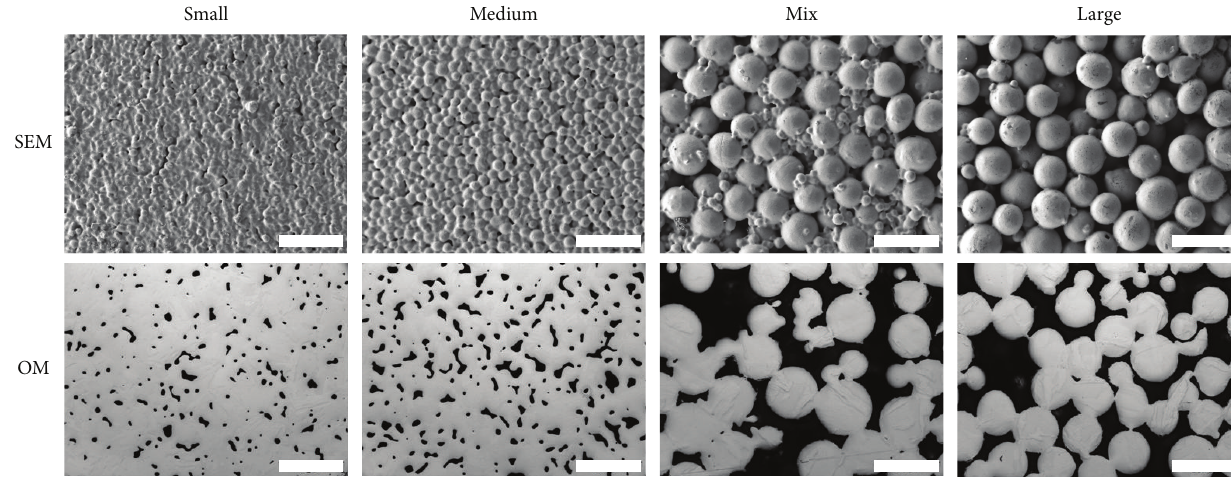
Figure 1: Material images. Scanning electron microscopy (SEM) and optical microscopy photographs (OM) of “Small,” “Medium,” “Mix,” and “Large” materials (scale bar 200 𝜇 m).